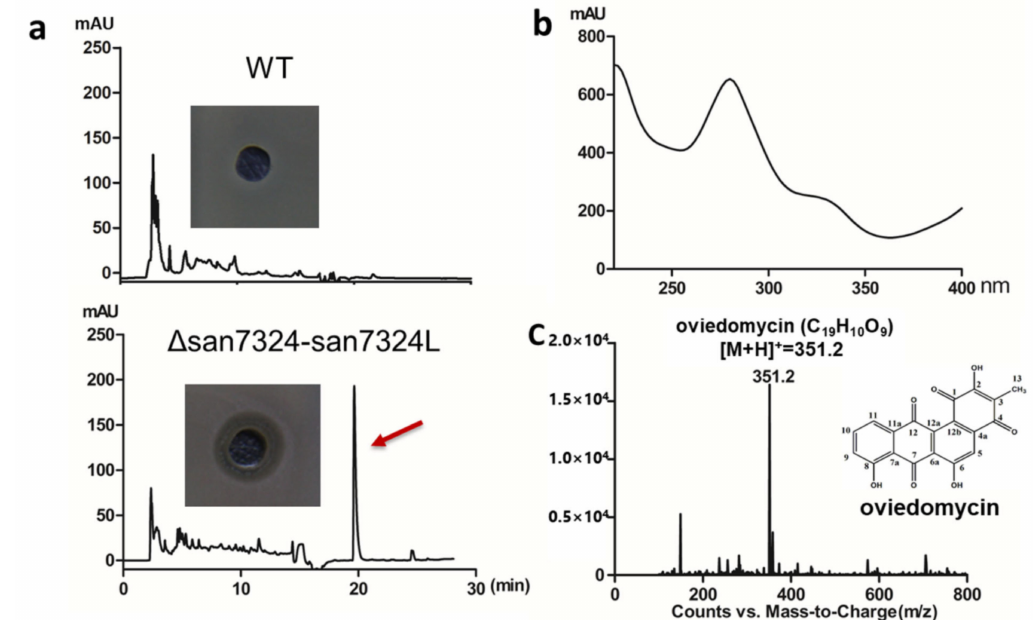
Figure 5. Identification of oviedomycin in S. ansochromogenes 7100 (WT) and ∆ san7324–7324L. ( a ) HPLC analysis of fermentation supernatant of WT and ∆ san7324–7324L. ( b ) UV absorption spectrum of oviedomycin. ( c ) Oviedomycin [M + H] + signal at m / z 351.2 was analyzed by MS and the structure was